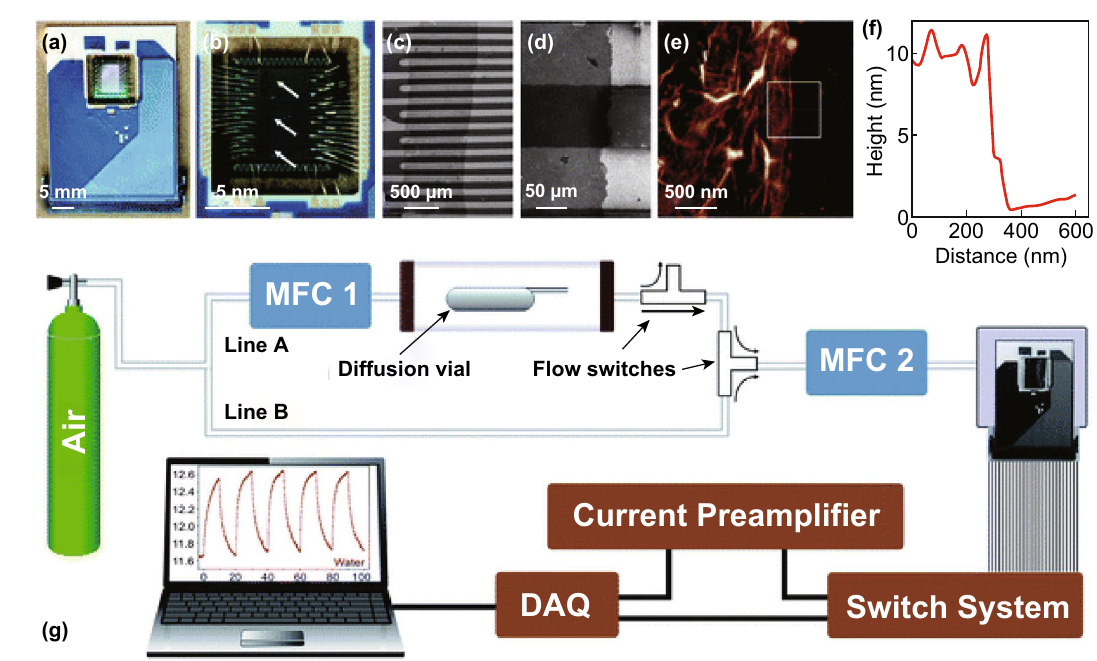
Fig. 5 a rGO-based multisensor array. b–e SEM and AFM images of the chip. f A height profile of the film. g Schematic of the experimental set-up for sensor measurements. Adapted with permission from Ref. [199]. Copyright 2013 Royal Society of